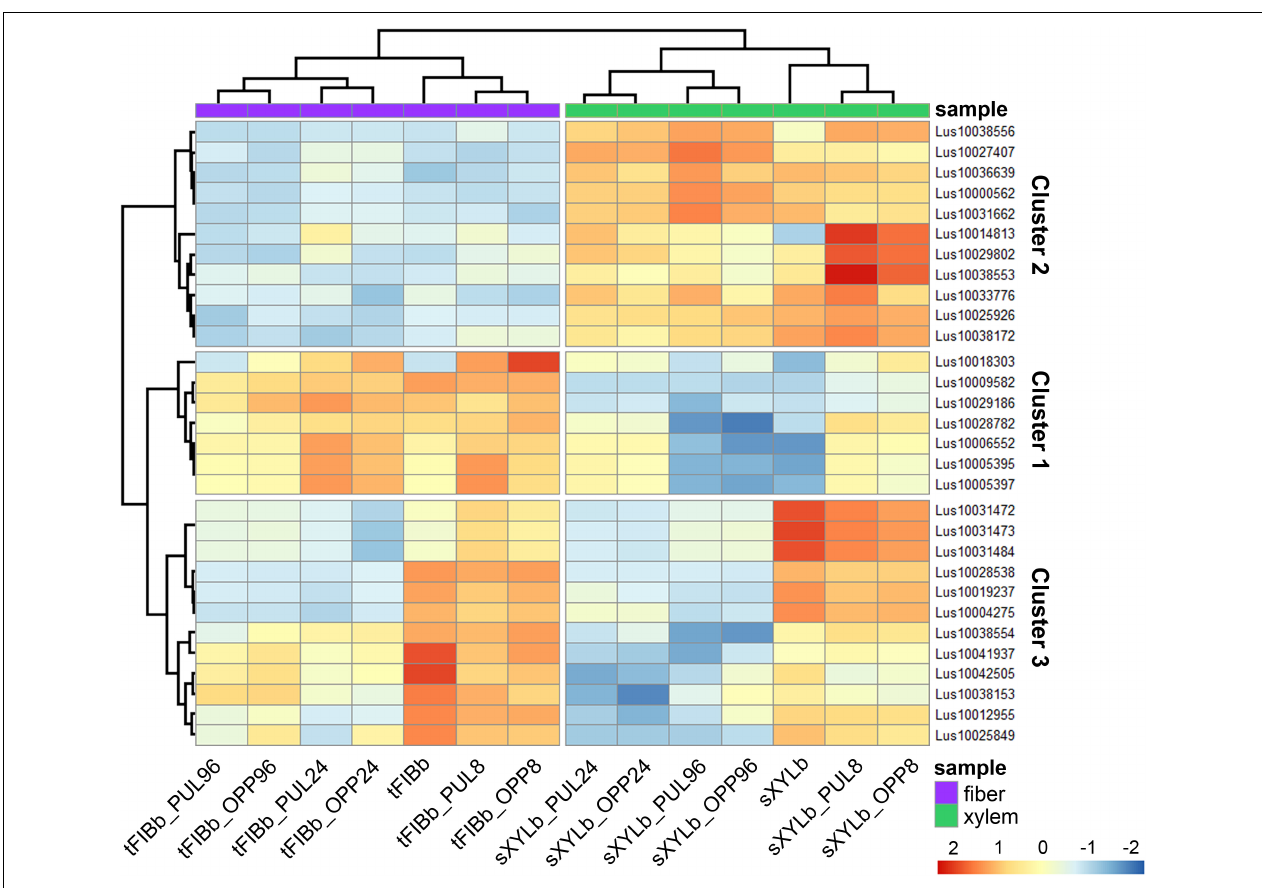
FIGURE 9 | Changes in expression of Linum usitatissimum genes for proteins with lectin domains during graviresponse. A heatmap of the top 30 lectin genes with the highest variance across samples from control plants (sXYLb and tFIBb) and from the segment with gravibending stems at various time points. Sample information is shown with colored bars at the top of the heatmap and abbreviations at the bottom. The color of the heatmap corresponds to the amount by which the variation of gene expression deviates from the gene’s mean variance across all samples. tFIBb and sXYLb – isolated fibers with TCW and stem xylem with SCW of non-inclined plant, respectively; tFIBb_PUL8, tFIBb_PUL24, tFIBb_PUL96 – isolated fibers with TCW from pulling side of flax stem after 8, 24, 96 h of gravibending, respectively; tFIBb_OPP8, tFIBb_OPP24, tFIBb_OPP96 – isolated fibers with TCW from opposite side of flax stem after 8, 24, 96 h of gravibending, respectively; sXYLb_PUL8, sXYlb_PUL24, sXYLb_PUL96 – pulling side of stem xylem with SCW after 8, 24, 96 h of gravibending, respectively; sXYLb_OPP8, sXYlb_OPP24, sXYLb_OPP96– opposite side of stem xylem with SCW after 8, 24, 96 h of gravibending. Abbreviations: SCW, secondary cell wall; and TCW, tertiary cell